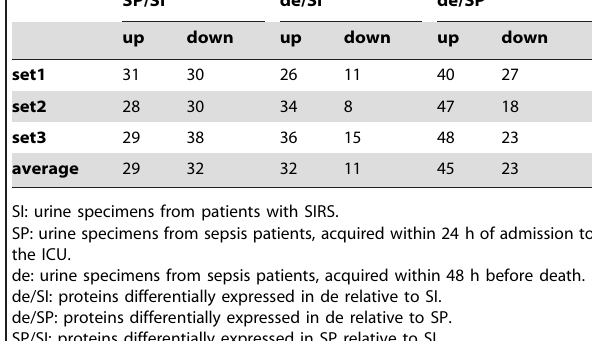
Figure 2. Proteins identified in the three sets (technical replicates).